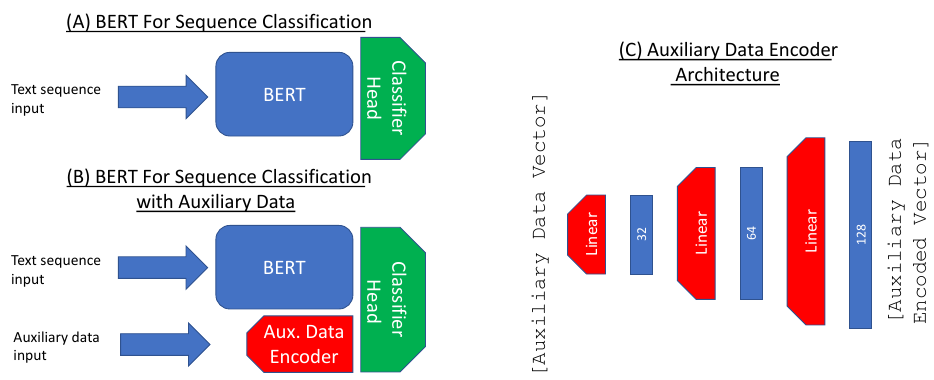
Figure 2. Visual representation of the model architectures used for classification. ( A ) Text sequence classifier: this model takes a contextual embedding of the input text using a BERT architecture and then feeds the embedding into a fully connected linear layer to output a classification. ( B ) Text sequence classifier with auxiliary data: this model uses a auxiliary feature encoder to build an encoded auxiliary data vector that is concatenated with the contextual embedding to use for